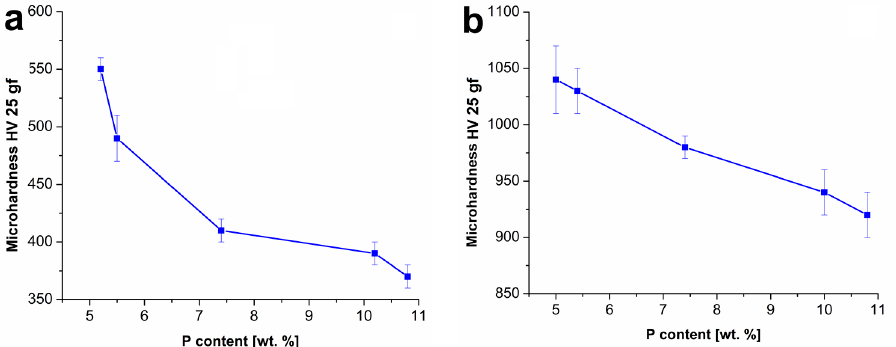
Figure 3. Microhardness dependence on the phosphorus content of Ni–P coatings, ( a ) as-deposited, ( b ) heat-treated.